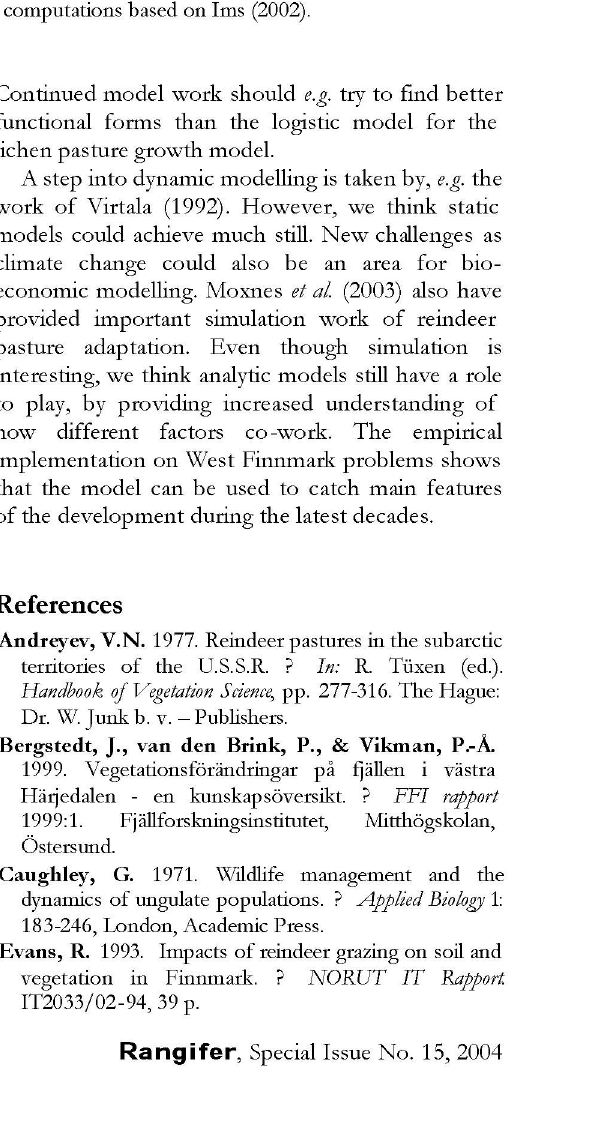
Fig. 16. Herd size development in major inner RPDs. Own computations based on Ims